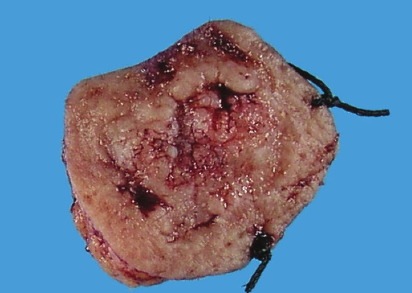
Figure 12: Meningioma: medium power magnification showing syncytial sheets and whorls of tumor cells with bland nuclear features. The presence of nuclear pseudoinclusions, psammoma bodies and the absence of atypia allow the distinction from SCC. (H&E, × 200).